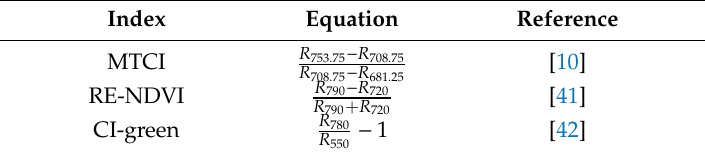
Figure 4. The measured spectra of rice plants between 450 nm and 850 nm.